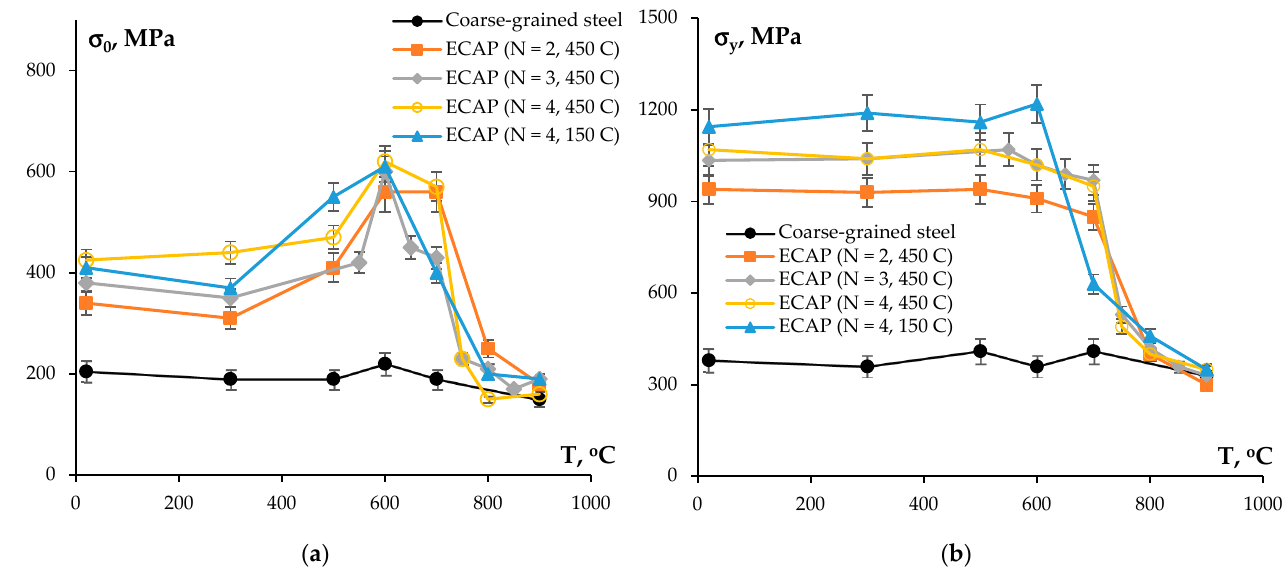
Figure 9. Dependencies of the macroelasticity stress ( a ) and yield strength ( b ) on temperatures during 1 hour annealing of UFG steel.